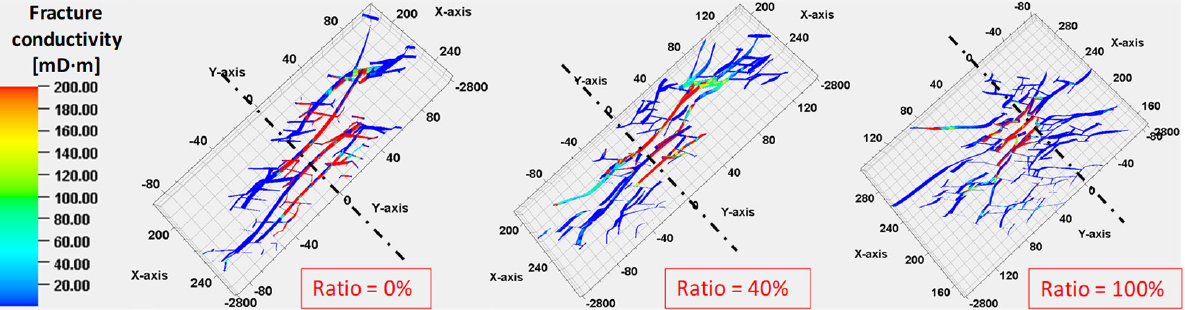
Figure 7. The F CD distribution of fracture system under the different ratios of slick water (zoom scale Z = 0.2 times).